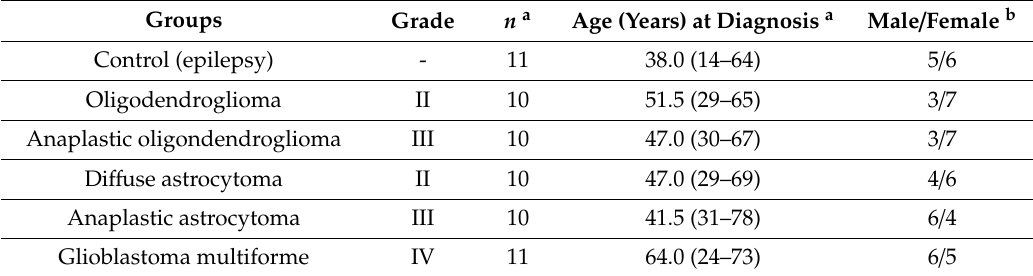
Table 1. Demographic and clinical characteristics of the immunohistochemistry study